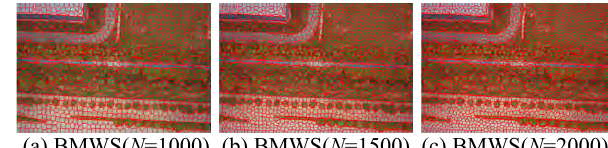
Figure 2. The result of the proposed BMWS algorithm when the number of superpixels is set to